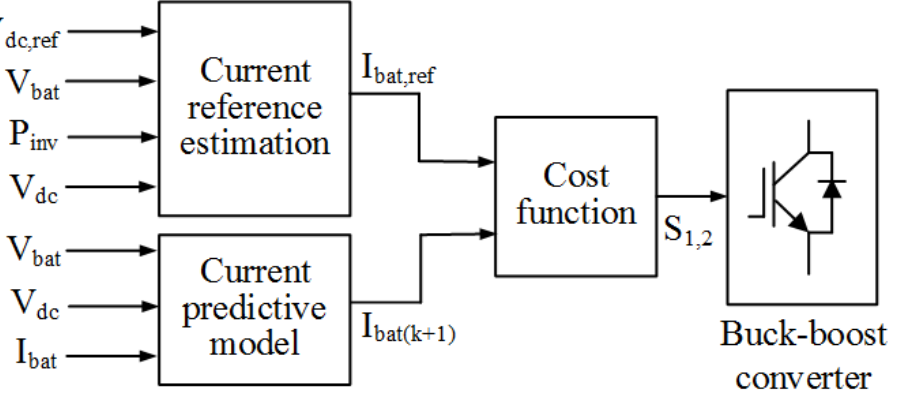
Figure 5. Diagram control of the predictive control algorithm for the DC-DC buck-boost converter.